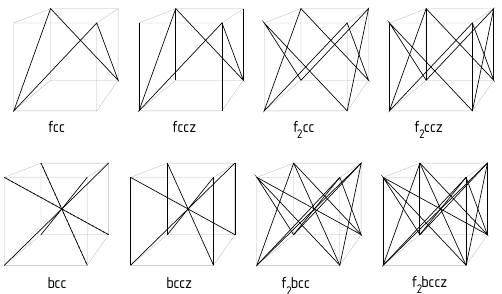
Figure 4. Possible lattice types for cubic unit